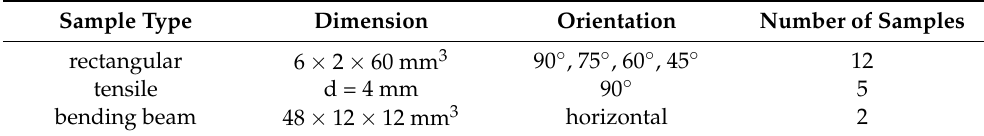
Table 2. Summary of the analyzed